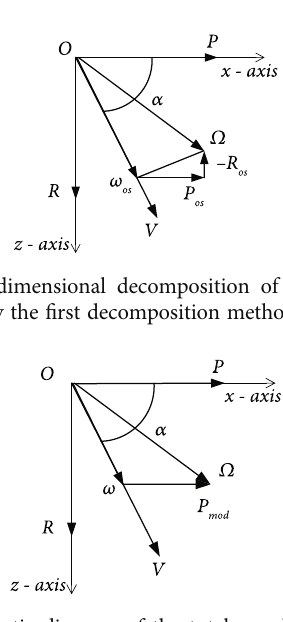
Figure 4: Schematic diagram of the total angular velocity vector decomposition by the second decomposition method.